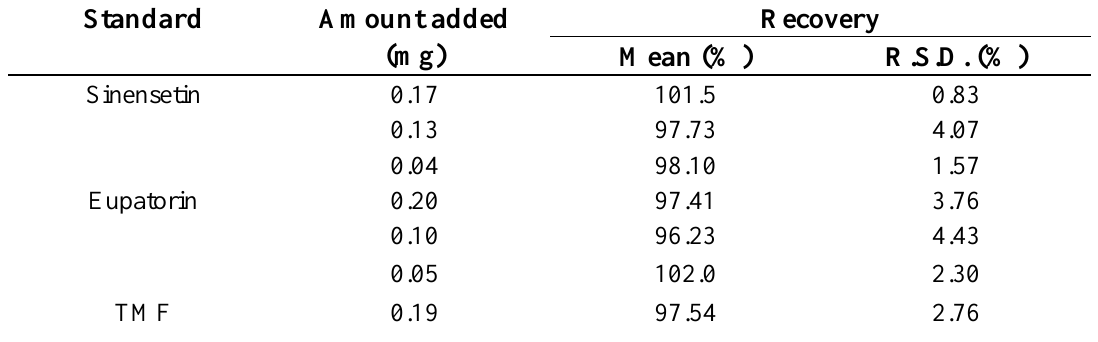
Table 1. Recovery of sinensetin, eupatorin and